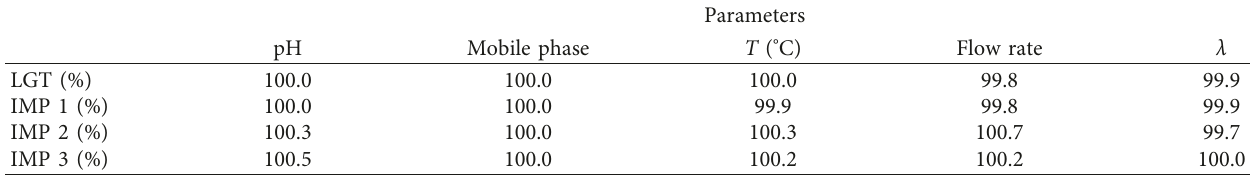
Table 4: Parameters evaluated and responses obtained on the robustness of LGT and synthetic impurities.